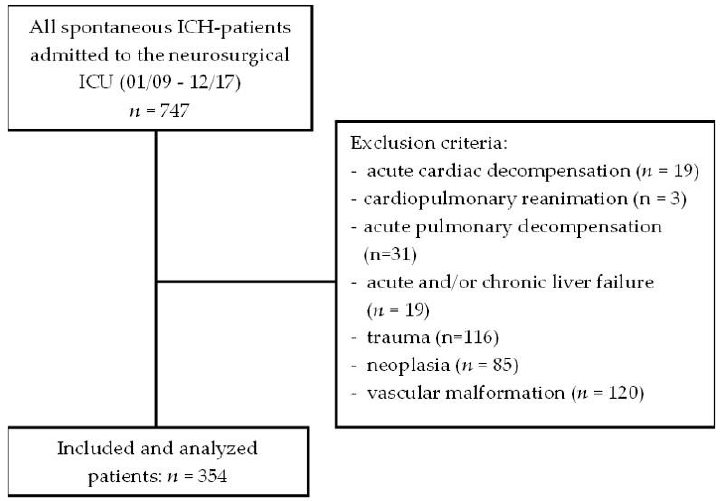
Figure 1. Flowchart for the inclusion and exclusion